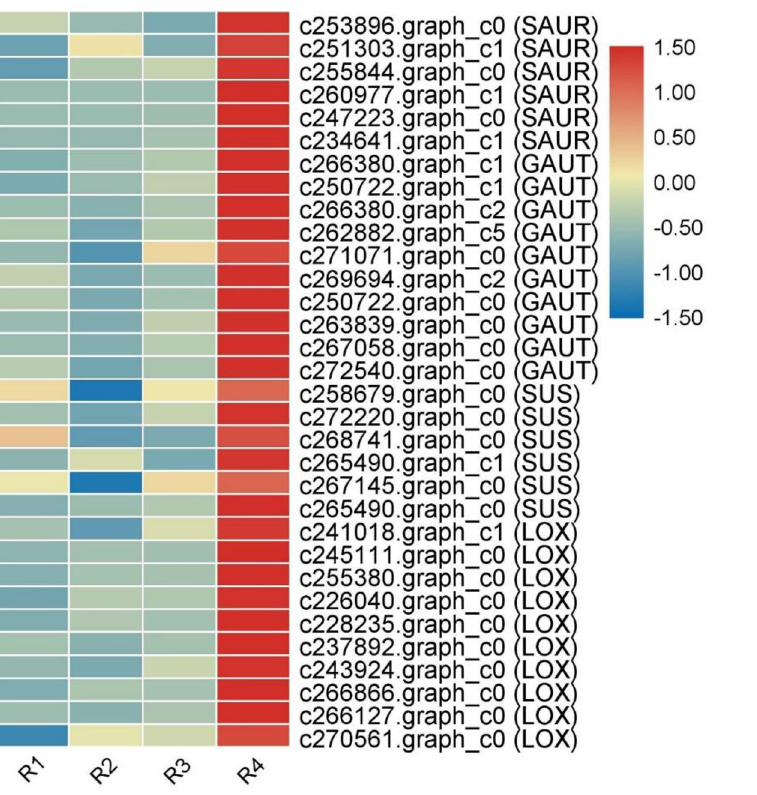
Fig 3. Heat map of highly expressed genes in R4.